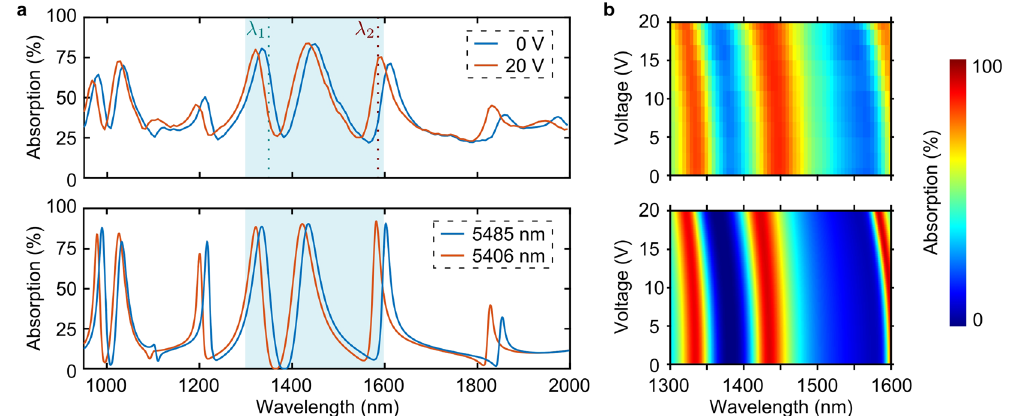
Figure 3. Electric tuning of absorption bands. ( a ) Absorption spectra measured with voltages U of 0 V and 20 V applied to the metadevice (top) and best fit theoretical absorption corresponding to metasurface-to-mirror spacings d of 5485 nm and 5406 nm based on equation (4) assuming the experimental detector bandwidth of 7 nm (bottom). ( b ) Experimental and theoretical absorption spectra as a function of voltage U , where theoretical spectra are calculated as above for cavity lengths d = d 0 − Δ d given by equation (1) with U P = 66 V and d 0 = 5485